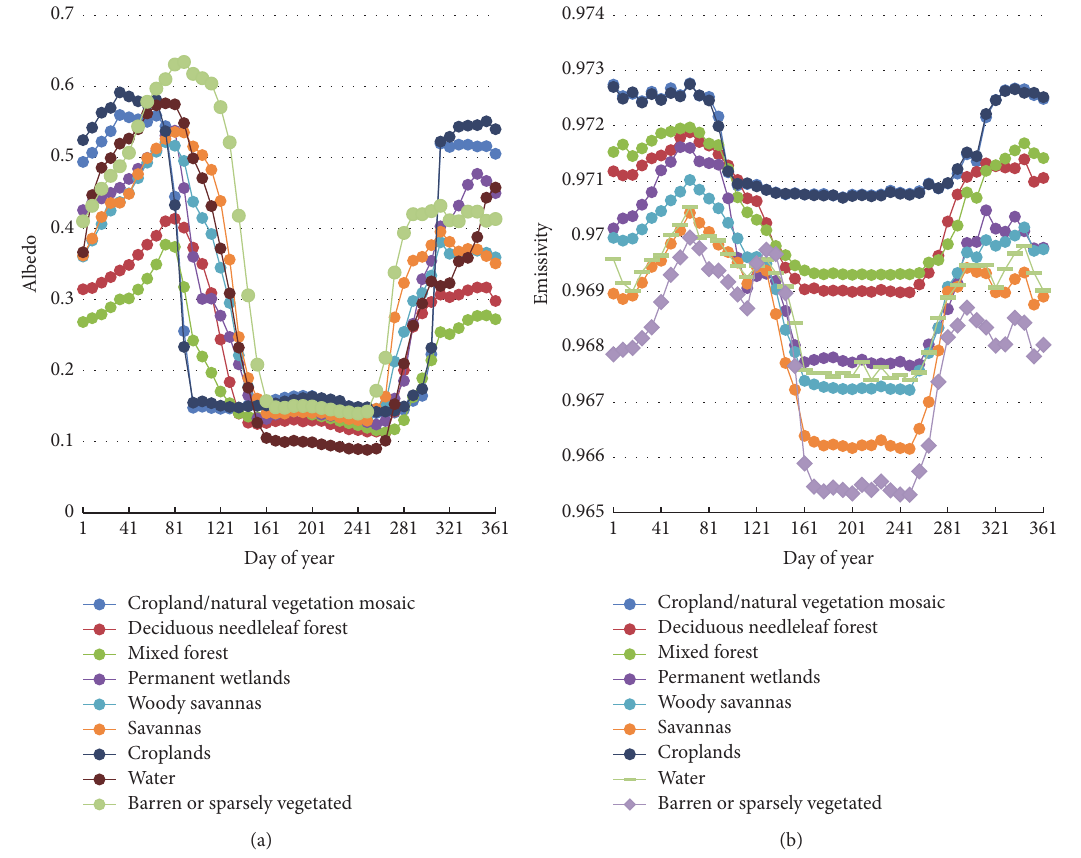
Figure 5: The average albedo (a) and emissivity (b) of each land cover class throughout the year in